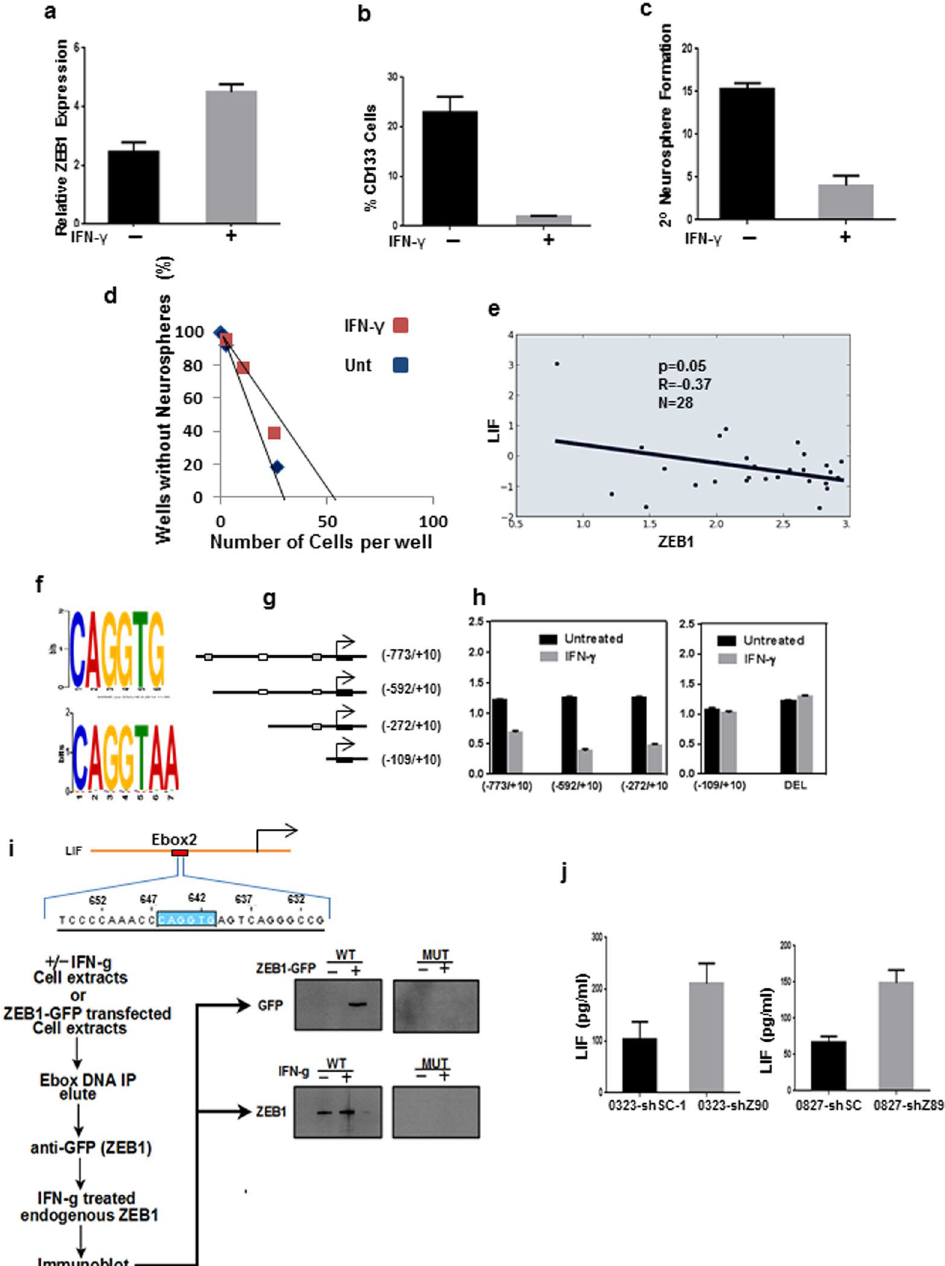
Figure 6. Effect of IFN- γ on LIF and ZEB1 activation in patient derived glioma cancer stem cells (GCSCs). ( a ) GCSCs were treated with IFN- γ for 3-days and ZEB1 expression levels were determined by qRT-PCR. ( b ) The percentage of CD133 + GCSCs in the presence and absence of IFN- γ were determined by flow cytometry. GCSCs were incubated with IFN- γ for 7-days. ( c ) The effects of IFN- γ on secondary neurosphere formation. ( d ) Limiting dilution sphere-forming assay indicated that cells not exposed to IFN- γ had increased self-renewal in vitro . ( e ) Spearman correlation between LIF and ZEB1 GBM patients ( n = 28), rank correlation (R) and two- tailed significance is shown. ( f ) ZEB1 binding motifs within the LIF promoter (CAGGTG, *** P < 0.0001 and CAGGTA, *** P < 0.0001). ( g ) Schematic of LIF deletion constructs. ( h ) GCSCs transfected with LIF luciferase deletion constructs − 773/ + 10, − 592/ + 10, − 272/ + 10, or − 109/ + 10 or with ZEB1 binding sites deleted/ mutated (DEL). The GCSCs were then incubated with IFN- γ to cause ZEB1 induction. ( i ) Oligonucleotide precipitation assay. Nuclear extracts from untreated GCSCs or GCSCs treated with IFN- γ were incubated with biotinylated double-stranded oligonucleotides corresponding to the putative ZEB1 binding motifs in the LIF promoter or a mutant version of that site (bottom western). Similarly, GFP-tagged ZEB1 was transiently transfected into GCSCs and the oligonucleotide precipitation assay was done (top western). ( j ) Determination of secreted LIF protein levels by ELISA after 72 hr treatment with IFN- γ of GCSCs 0323 (left) and 0827 (right). Error bars represent the mean of ± SEM of at least 3